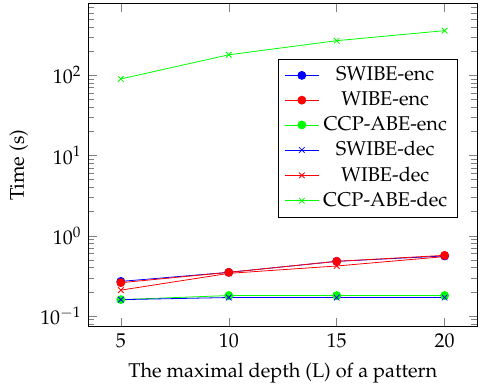
Figure 1. Encryption and decryption time in SWIBE, WIBE, and CCP-ABE.